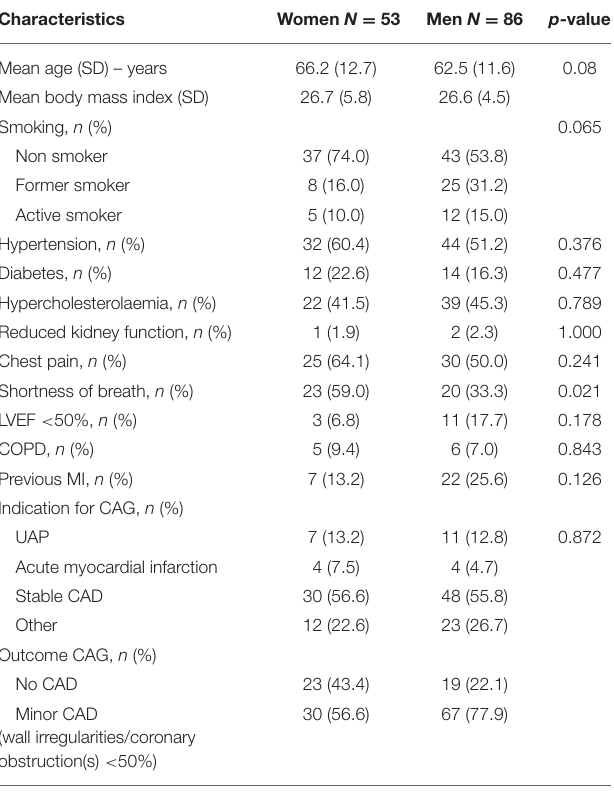
TABLE 1 | Baseline characteristics of women and men with non-obstructed coronary arteries. Characteristics